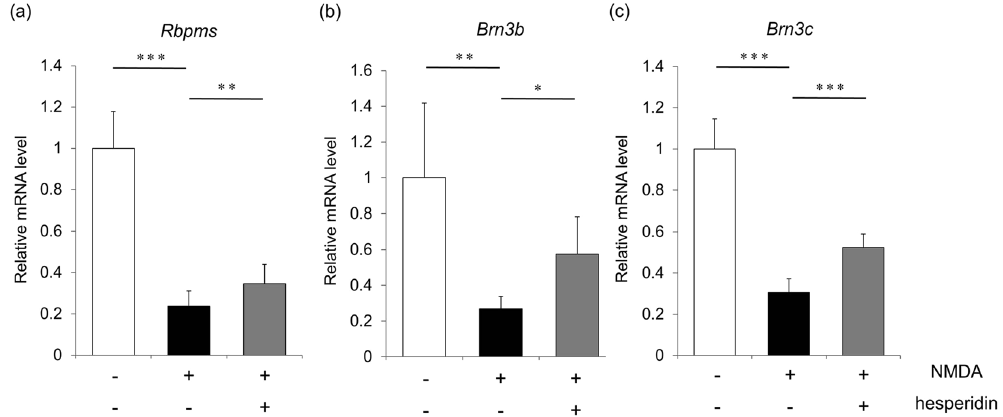
Figure 2. Gene expression of RGC markers in NMDA-injured mouse retinas with and without hesperidin treatment. The transcriptional levels of Rbpms ( a ), Brn3b ( b ) and Brn3c ( c ) were compared in the eyes of mice treated with PBS without NMDA (white bars), treated with PBS (black bars), and treated with hesperidin (gray bars) 24 h after NMDA injection. The gene expression of each RGC marker was normalized to Gapdh. Expression levels are shown as percentages of the average expression in eyes treated with PBS without NMDA. Data represent mean ± SD (Rbpms: n = 14, Brn3b, Brn3c: n = 6 each). * p < 0.05, ** p < 0.01, *** p <